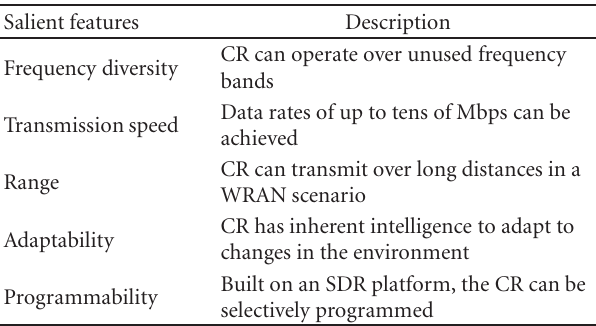
Table 2: Advantages of applying cognitive radio to smart